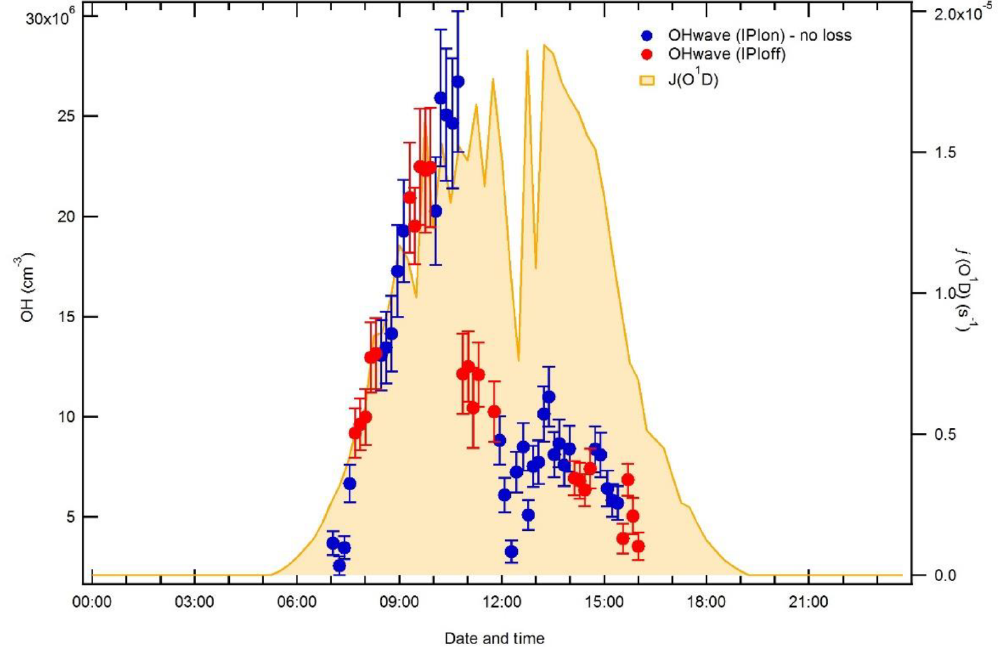
Figure 4. Time series of OH wave concentrations in Beijing on 17 June 2017, a period of high OH levels in the summer 2017 AIRPRO (an integrated study of AIR pollution PROcesses in Beijing) campaign. Blue and red markers ( ± 1 σ ) denote observations made with and without the IPI system,